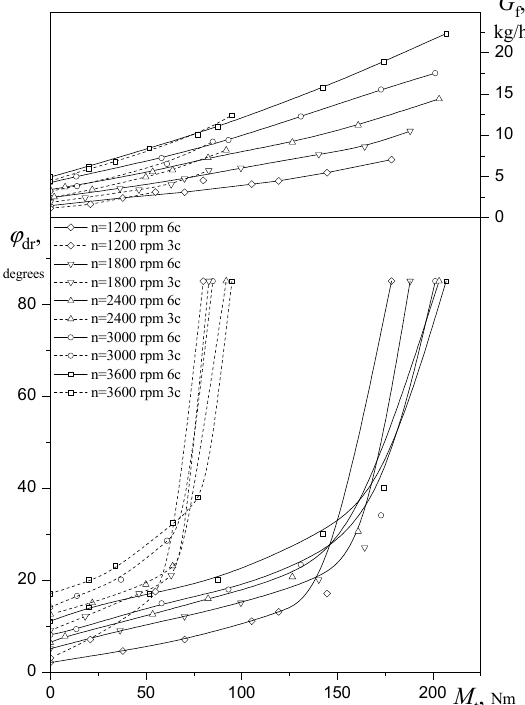
Figure 10. The dependencies of hourly consumption of gasoline and angles of opening throttle flaps on the torque of the Opel C30 LE engine. The 6c shows that engine operation on six cylinders; 3c: engine operation on three cylinders.